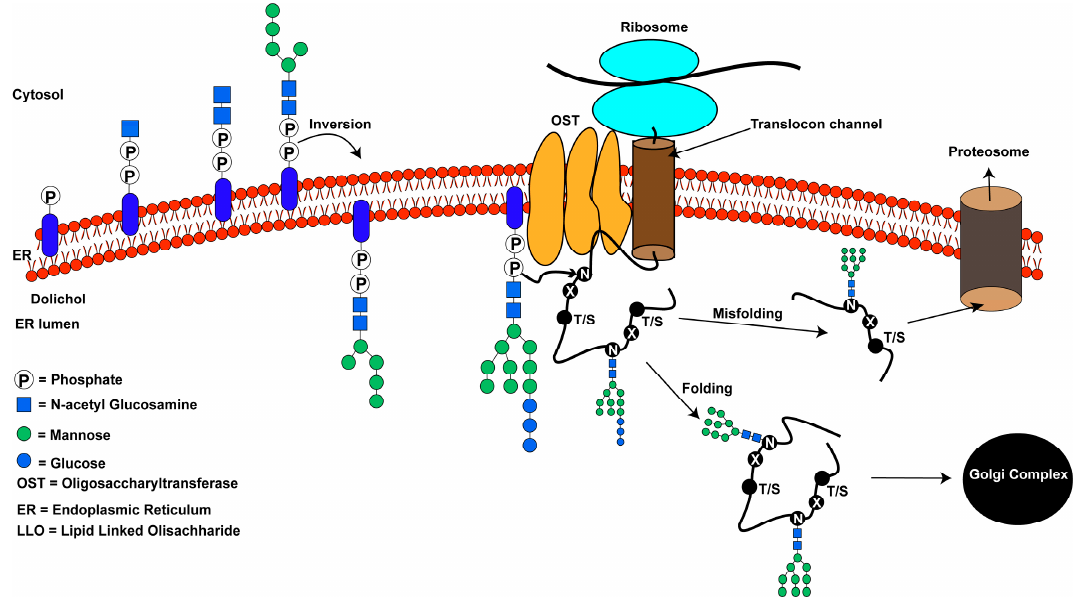
Figure 1. An overview of the N -linked glycosylation reaction of proteins in higher eukaryotes: pyrophosphate and monosaccharides are added to the dolichol lipid on the cytosolic side of the endoplasmic reticulum. The lipid linked oligosaccharide (LLO) is inverted to the luminal side of the endoplasmic reticulum (ER). Additional monosaccharides are added to form the mature LLO. Oligosaccharyltransferase (OST) catalyzes the transfer of the oligosaccharide from the LLO to the side-chain of an asparagine residue in -N-X-T/S- consensus sequence within a protein. Protein folding occurs after N -linked glycosylation. The three terminal glucose residues are trimmed before translocating to the Golgi apparatus for sorting. Misfolded proteins are targeted for degradation by proteasomes.